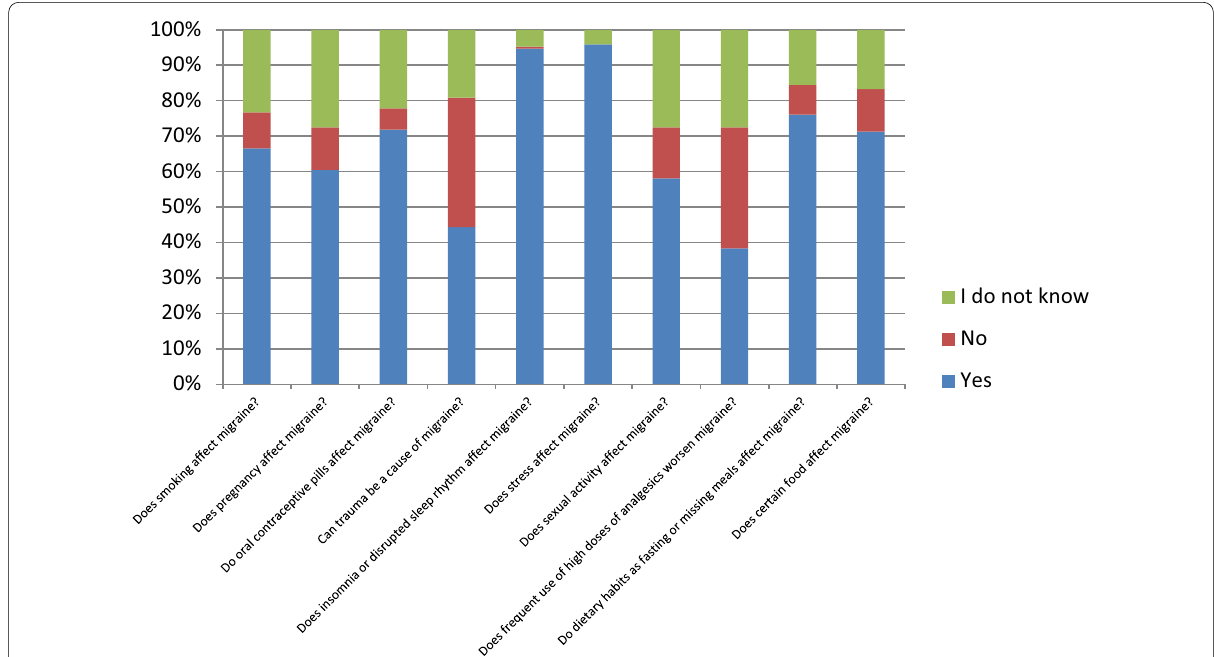
Fig. 1 Knowledge regarding precipitating factors of